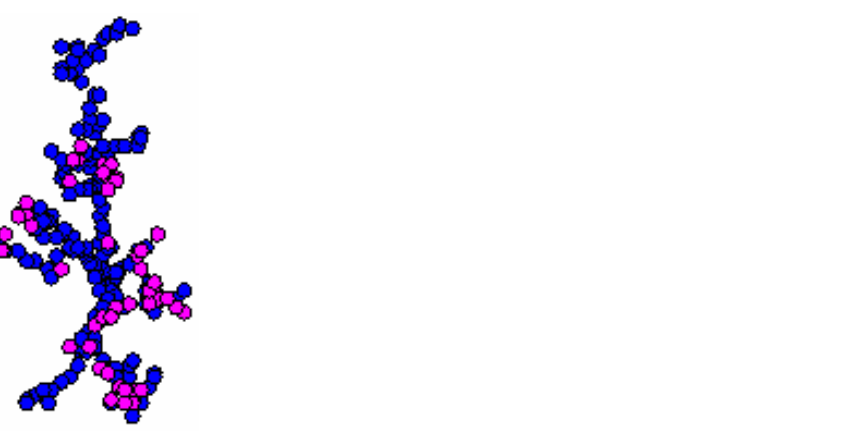
Figure 3. Computer simulation result within the diffusion-limited aggregation model.